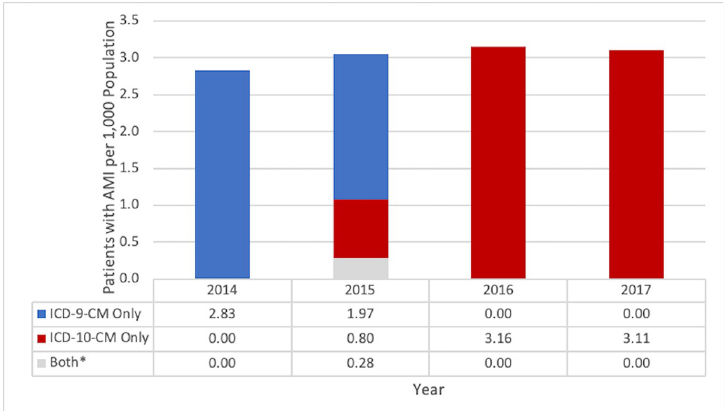
Fig 1. Proportion of patients with AMI per 1,000 enrolled individuals according to year (2014–2017). Abbreviations: AMI, acute myocardial infarction. � Note: In 2015, 6,273 of 67,375 patients (9.3%) received both an ICD-9-CM and ICD-10-CM diagnosis for AMI, in the January–September and October–December timeframe, respectively. These patients were only counted once for proportion estimates (using the “Both”